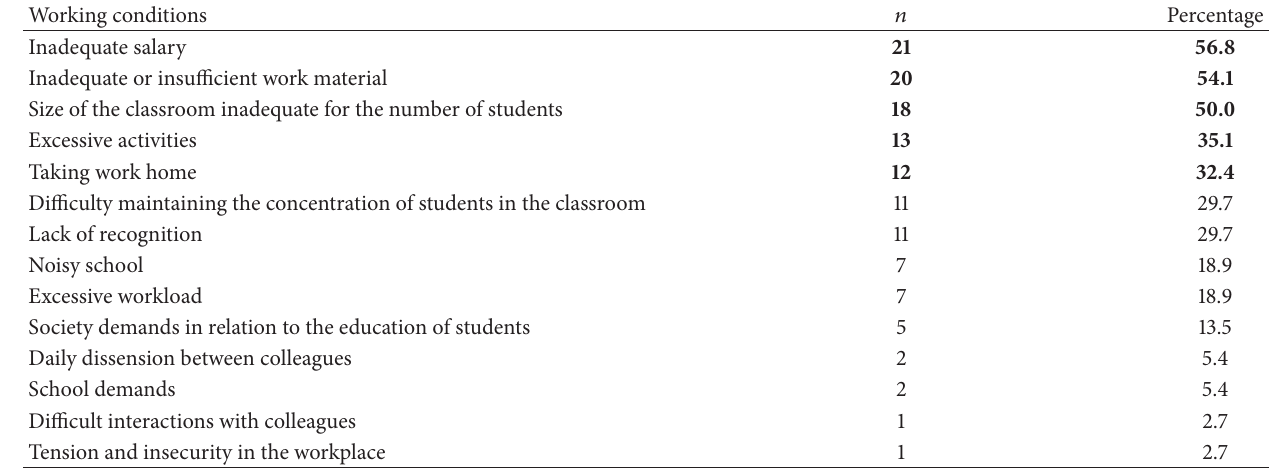
Table 2: Frequency of stressful working conditions in the school as self-reported by elementary schoolteachers.